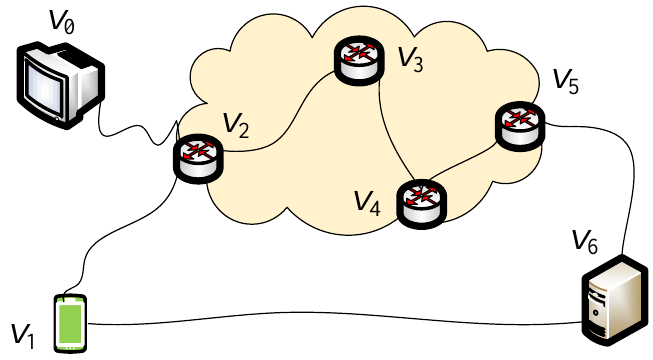
Figure 2. Simplified model of an SCN for the graph-theoretic approach.